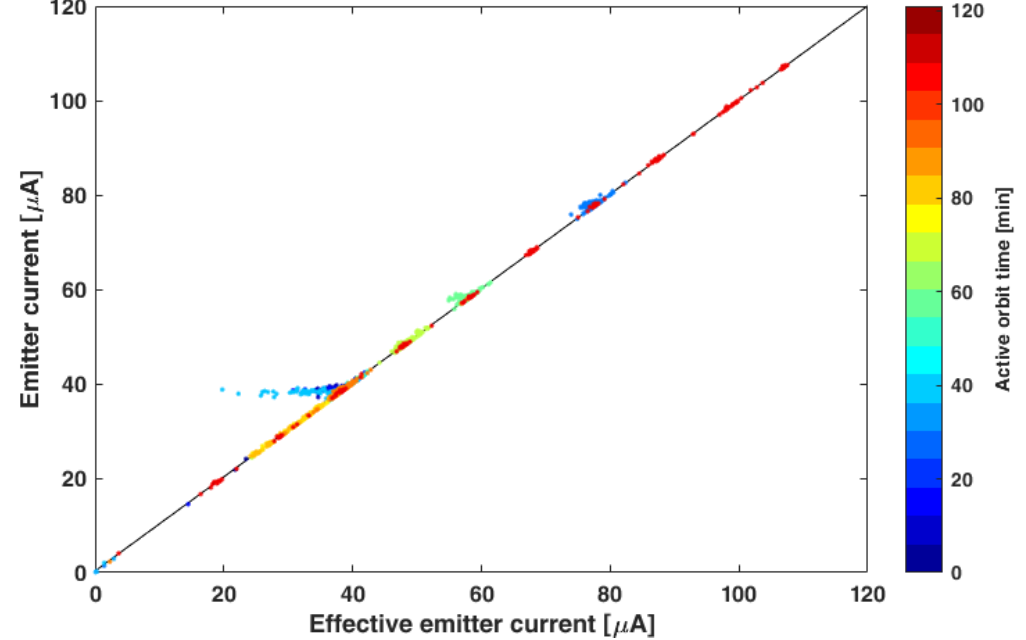
Figure 11. Effective emitter current vs. emitter current of thruster A. The active time in orbit is encoded in the color. A black linear trend line following Equation (13) is under the